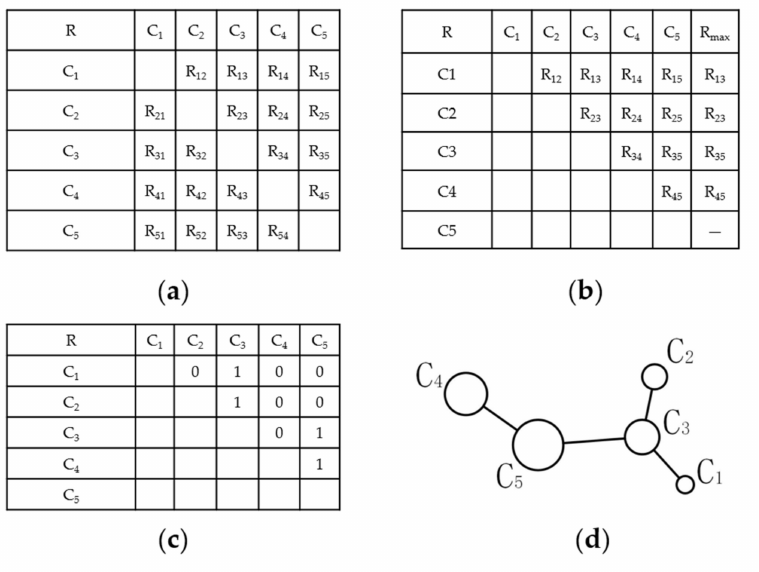
Figure 2. Process used to identify the hierarchical network structure of urban and rural settlements: ( a ) Spatial interaction matrix R ; ( b ) Spatial interaction matrix R ij ( i < j ) ; ( c ) Spatial interaction 0–1 matrix; ( d ) Hierarchical network